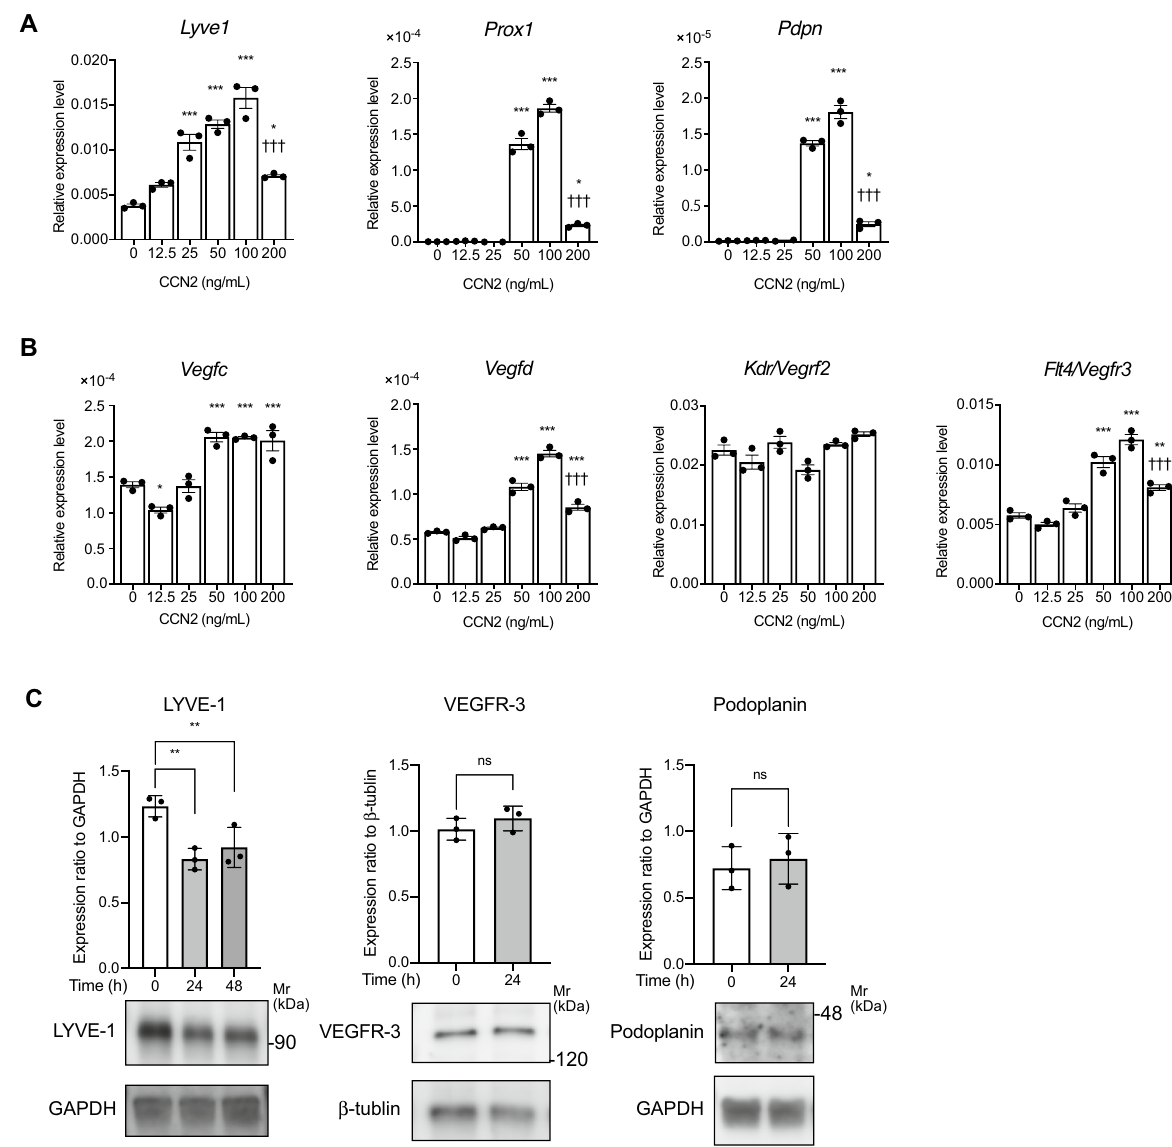
Figure 2. Expression levels of lymphatic endothelial markers in CCN2-treated LECs. Mouse primary cultured LECs were treated with 0, 12.5, 25, 50, 100 or 200 ng/mL CCN2 for 3 h. ( A ) mRNA expression levels of Lyve1 , Podoplanin and Prox1 were analyzed by quantitative RT-PCR. ( B ) Vegfc, Vegfd, Kdr (encoding VEGFR2) and Flt4 (encoding VEGFR3) mRNA levels were analyzed by quantitative RT-PCR. Actb was used as an internal control, and gene expression levels were expressed relative to Actb mRNA. One-way ANOVA, * p < 0.05, ** p < 0.01, *** p < 0.001 versus 0 ng/mL CCN2. ††† p < 0.01 versus 100 ng/mL CCN2. ( C ) LECs were treated with 100 ng/ml CCN2 for 24 h, and protein expression levels of LYVE-1, VEGFR3, and Podoplanin were detected by Western blotting. One-way ANOVA, ** p < 0.01 versus 0 h. Student t test, ns; not function-blocking antibody against integrins αvβ3 and αvβ5 compared with IgG isotype control. In particular, the blockade of integrin αvβ5 almost completely blocked the phosphorylation of ERK by CCN2 (Fig. 4E). These results indicate that CCN2 activates ERK via integrins αvβ3 and αvβ5 in LECs and that integrin αvβ5 is predomi- nant in CCN2 signaling in LECs. In contrast, knockdown of integrin α9 and β1 resulted in a slight increase of CCN2-induced phospho-ERK compared with levels in cells transfected with non-target siRNA (Supplementary Fig. S5A,B). Itgb2 and Itgb3 mRNA levels were not changed by suppression of integrin β1, which suggests that integrins β2 and β3 may not compensate for the decrease in integrin β1 (Supplementary Fig. S5C). CCN2- mediated cell adhesion via integrin αvβ3 exhibited the absolute requirement for heparan sulfate proteoglycans (HSPGs), and destruction of cell surface HSPGs with heparinase abrogated cell adhesion to CCN2 17 . To substan- tiate the finding that HSPGs are required for CCN2-induced ERK activation in LECs, LECs were treated with heparinase I, an enzyme that targets highly sulfated HSPGs. In heparinase I-treated cells, ERK phosphorylation